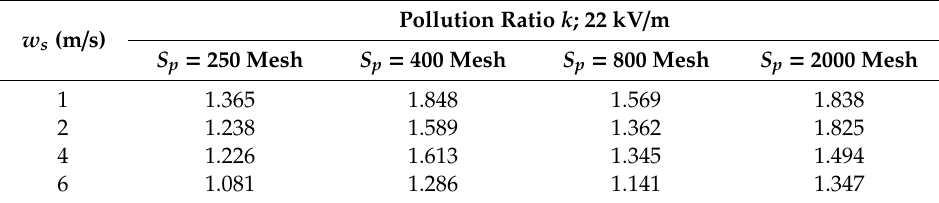
Table 8. Pollution ratio k under electrical stress of 22 kV /